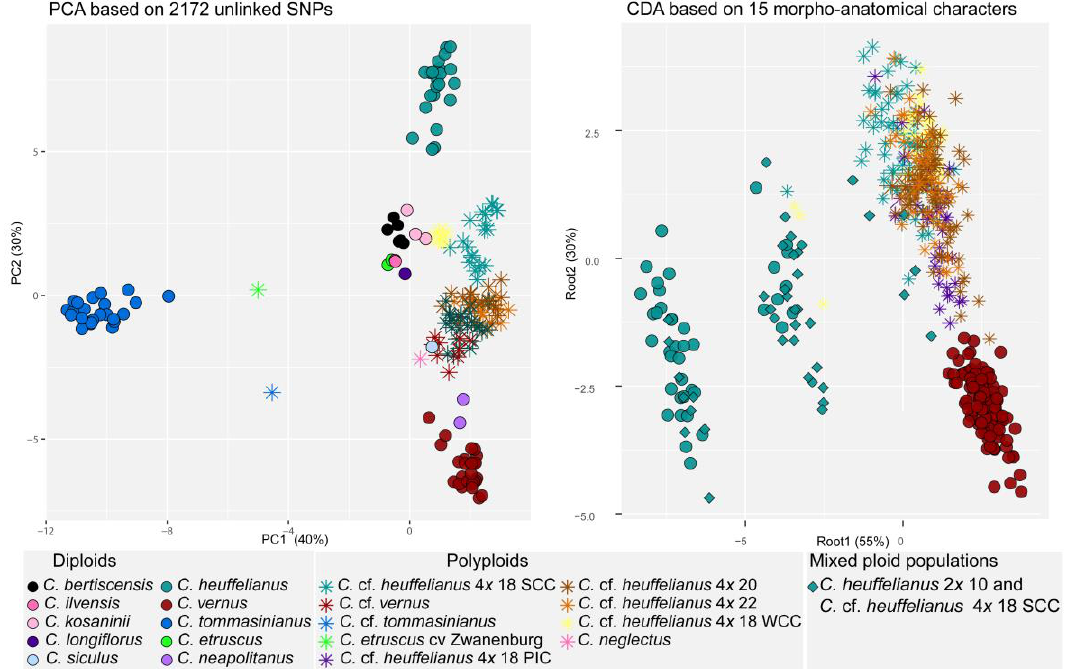
Figure 6. PCA based on 2127 unlinked GBS-derived SNPs ( left panel ) comprising all species of Crocus ser. Verni , and CDA based on 15 morpho-anatomical characters ( right panel ) of C. vernus , C. heuffelianus, and C . cf. heuffelianus .